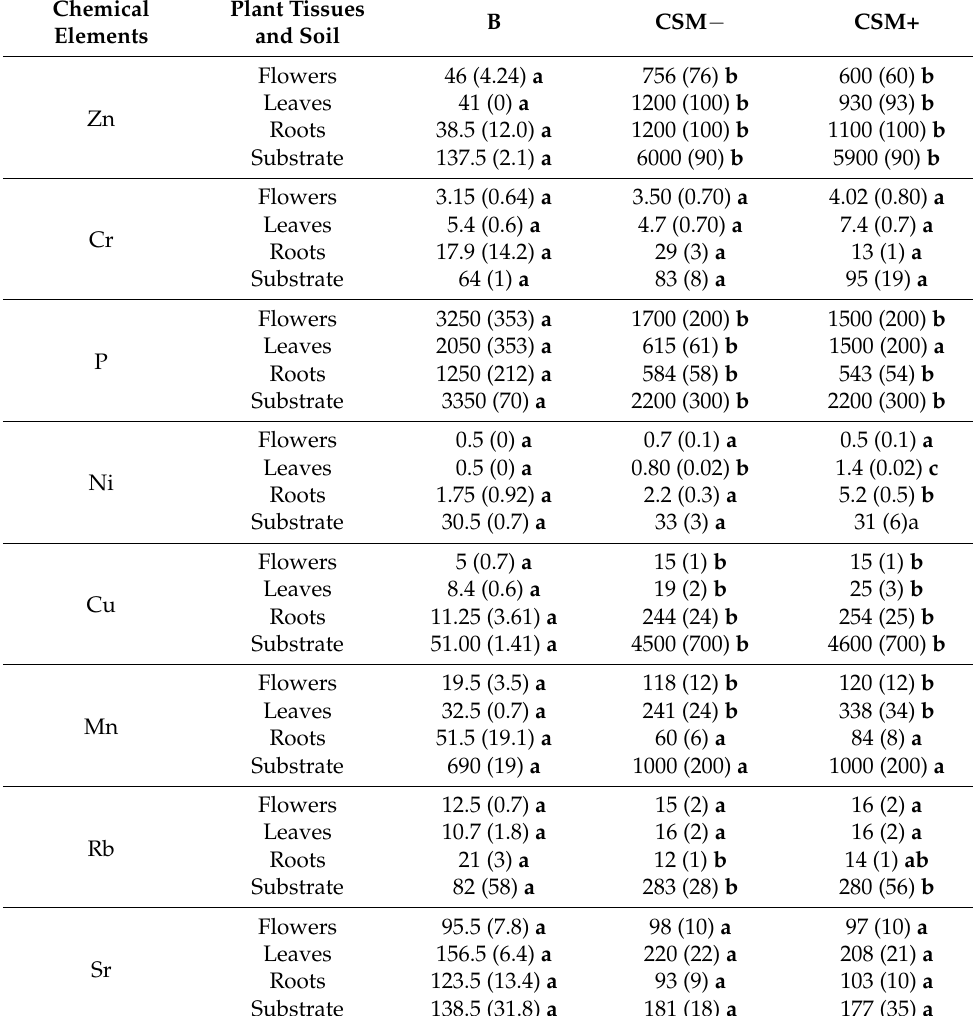
Table 2. Raw materials concentration (ppm) in the different plant tissues of Helianthus annuus inoculated (CSM+) and uninoculated (CSM − ) with the arbuscular mycorrhizal fungus Rhizophagus intraradices GA5 strain, when grown in contaminated mine soil + volcanic ash + Zn (CS) and control blank soil